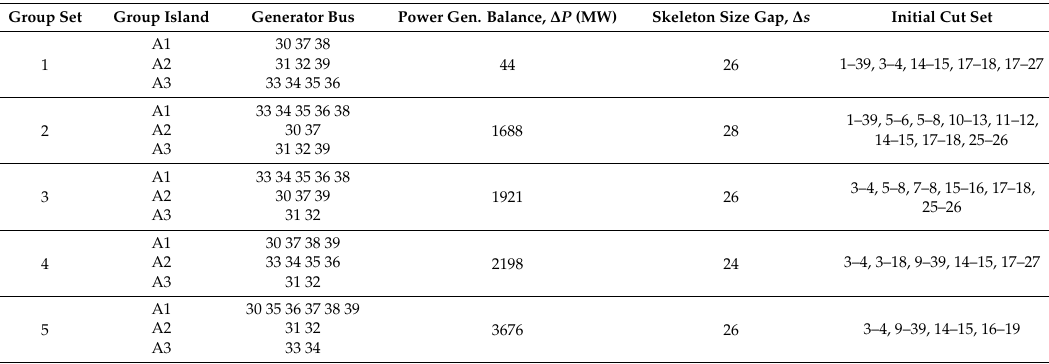
Table 3. Heuristic technique for IEEE 39 test system.